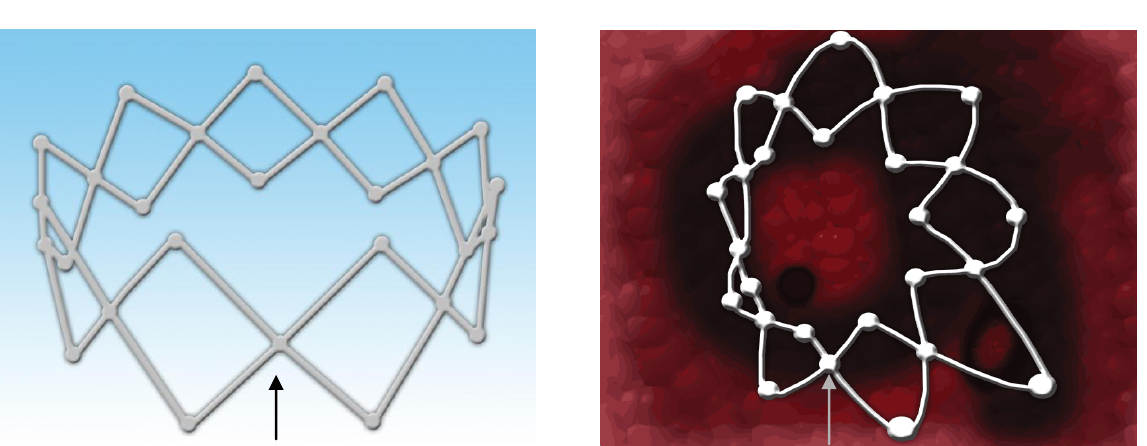
Figure 5. Mometasone-loaded ( A ) spring-like Propel™ sinus implant expands when placed into the sinus mucosa ( B ), thus keeping the middle meatus open and hence, promoting mucous drainage and wound